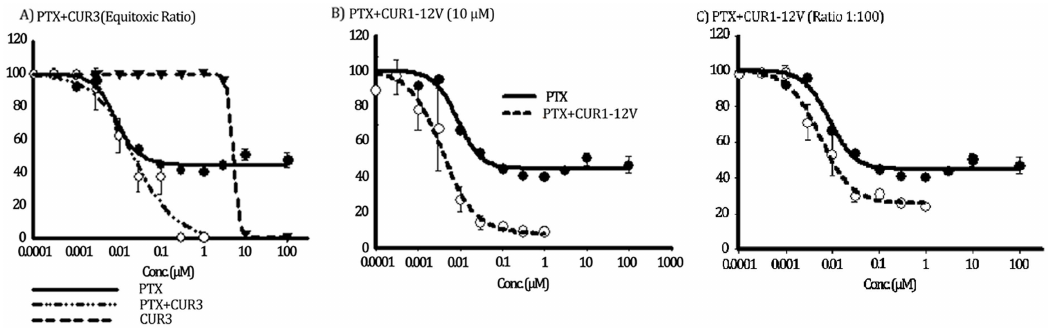
Fig 5. The effect of serial equitoxic concentrations (ratio 1:100) of Cur3 (A), and 10 μ M (B), and serial concentration of Cur1-12V(ratio 1:100) (C) on the cytotoxicity of PTX in LS-174T cells. Cells were exposedto serial dilutionof PTX ( ● ), Chemosensetizer( ▼ ) or their combination ( ○ ) for 72 h. Cell viabilitywas determinedusing SRB